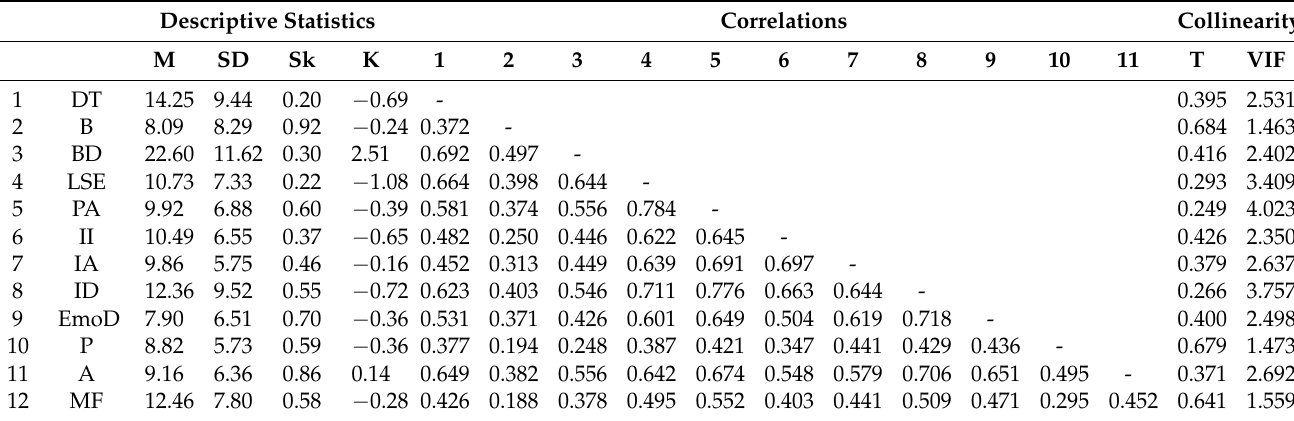
Table 1. Descriptive statistics of questionnaires (row scores) and correlations between